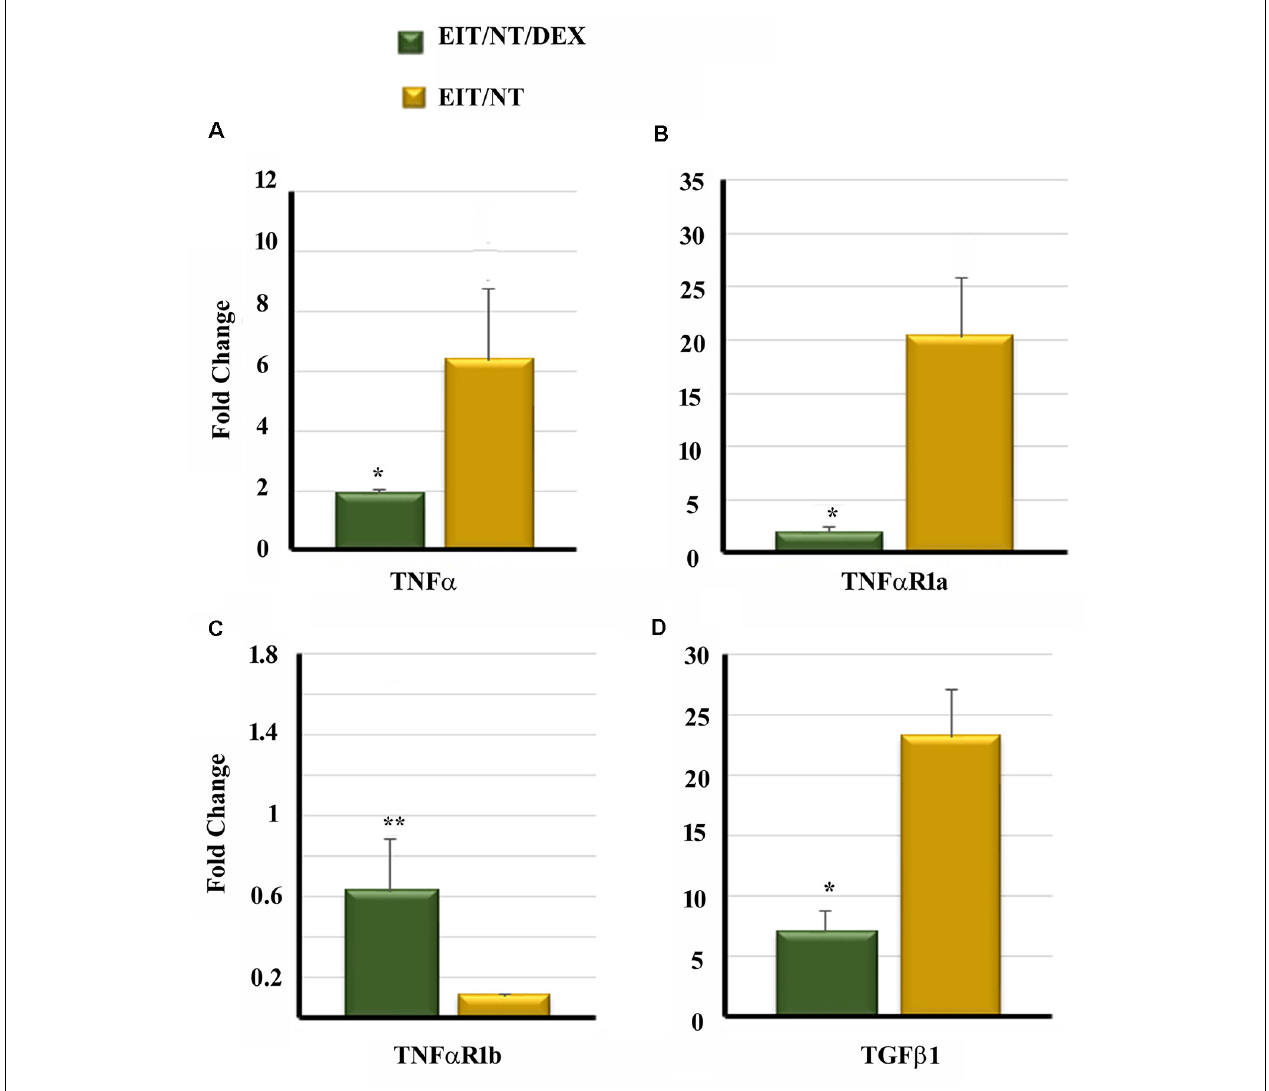
FIGURE 6 | Dexamethasone significantly decreases the expression of pro-inflammatory and pro-fibrogenic genes in the cochleae. Guinea pigs were implanted with dexamethasone or non-drug-eluting electrodes and subjected to NT. Cochleae were harvested at different time periods. The expression of TNF- α (A) , TNF α R1a (B) , TNF α R1b (C) and TGF β 1 (D) was determined by real-time PCR. ∗ P < 0.01 or ∗∗ P > 0.05 compared to EIT/NT group. Data are expressed as fold change compared to control group and represents the mean ± standard